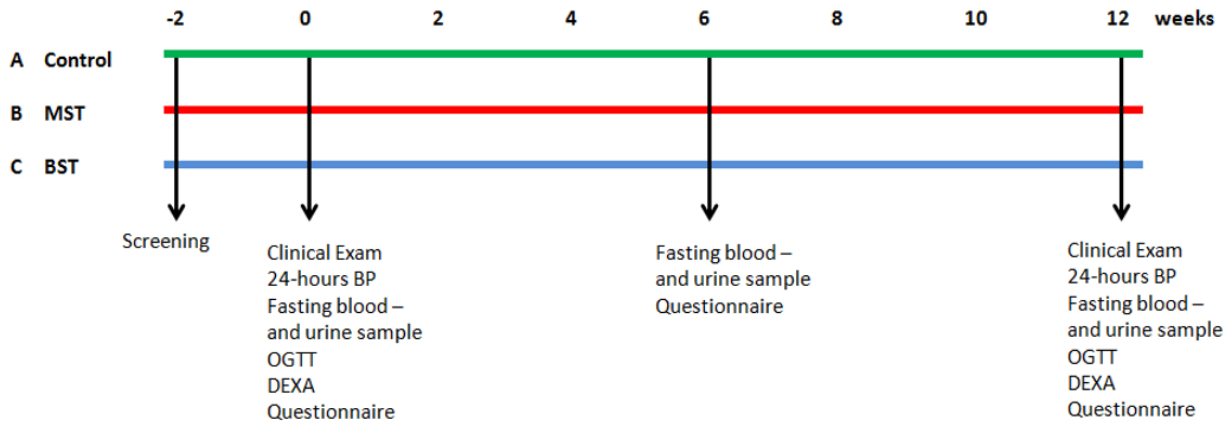
Figure 1. The study design. The far left shows the three groups in the top ( A ) the control group (green); ( B ) mild and sweet tasting (red); and finally ( C ) bitter and strong tasting (blue). Screening took place approximately 2 weeks prior to project start. At weeks 0 and 12, fasting blood and urine samples were taken, 24 h blood pressure (BP) and oral glucose tolerance test (OGTT) were performed, and DEXA scans were conducted. At weeks 0, 6, and 12, participants filled out thorough questionnaires. Randomization took place at week 0.